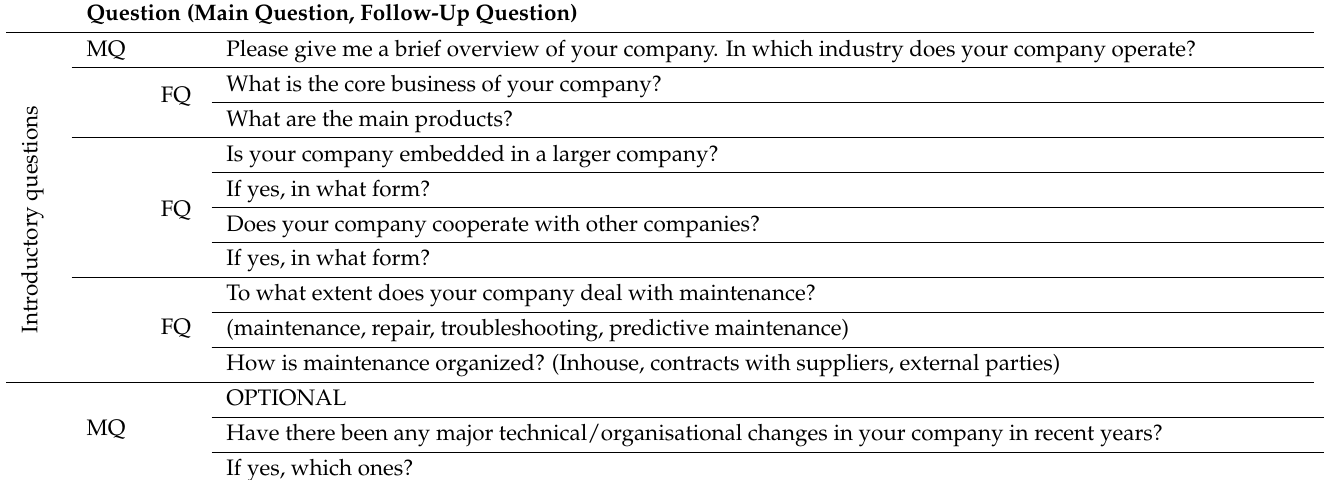
Table A1. The following are the questions from the interview